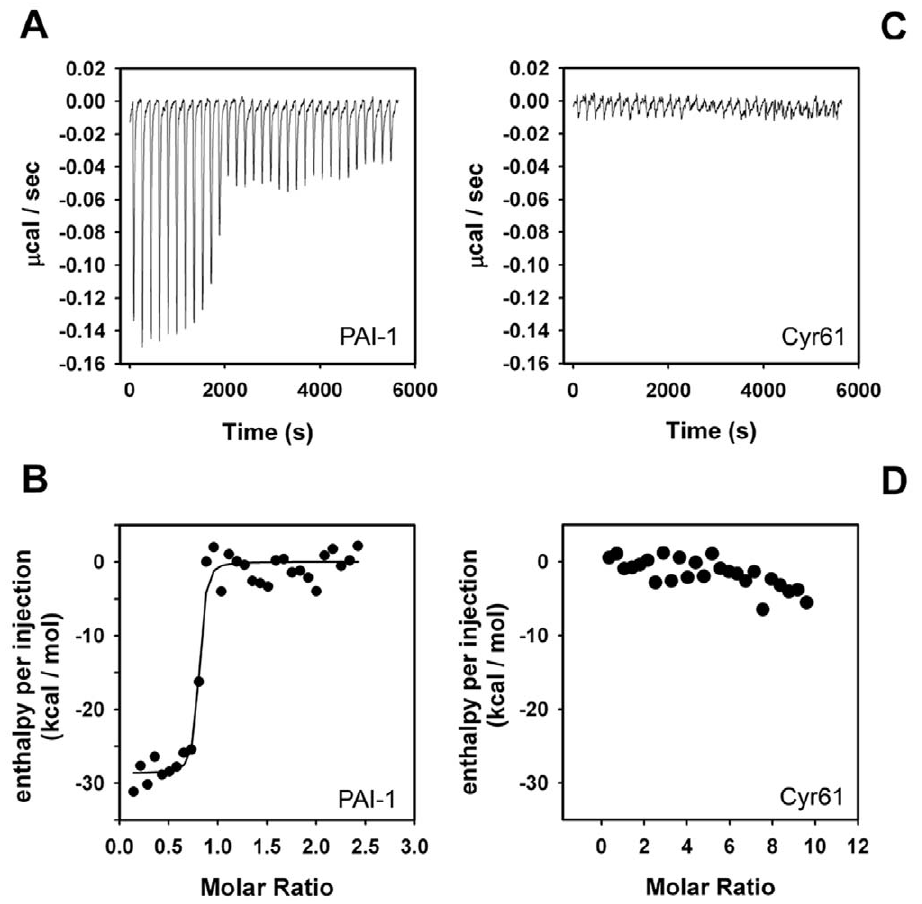
Figure 4. Cyr61 does not interact with SMTB 1–44 domain in solution. ( A ) Isothermal titration calorimetry for stable mutant PAI-1 interaction with SMTB 1–44 . Base line-adjusted heats per injection of SMTB 1–44 (10 m M) into PAI-1 (1.0 m M). ( B ) Molar enthalpies per injection for PAI-1 interaction with SMTB 1–44 . Filled circles, measured enthalpies; solid line, fit of experimental data to a single-site binding model. Thermodynamic parameters: D H = 2 24 6 1.34 kcal/mol. ( C ) Base line-adjusted heats per injection of SMTB 1–44 (10 m M) into Cyr61 (1.0 m M). ( D ) Molar enthalpies per injection for SMTB 1–44 interaction with Cyr61 where no heat exchange is observable. Filled circles, measured enthalpies.